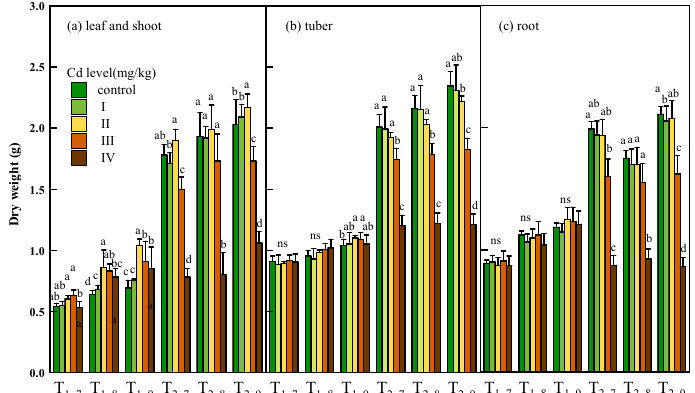
Figure 2. Dry weight of leaf and shoot ( a ), tuber ( b ) and root ( c ) of Bletilla striata ( B. striata ) plants under Cd treatment control, I, II, III and IV. T i–j means B. striata harvested at a certain point (i = 1,2, represents the year after transplanting; j = 7,8,9, represents the month for sampling). Values demonstrate means ± SD ( n = 3). Significant effects of each treatment on values for dry weight are denoted by different lowercase letters (one-way ANOVA, p < 0.05).